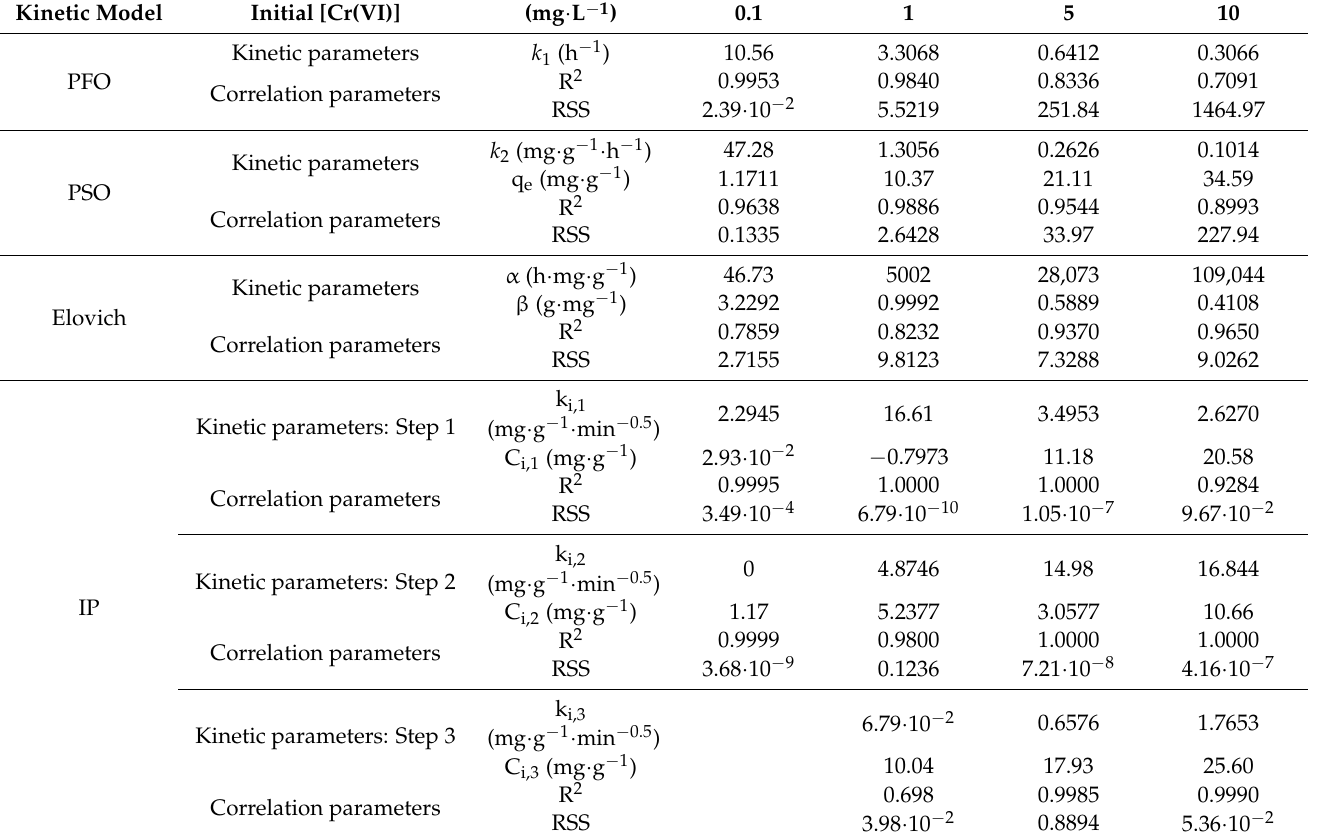
Table A3. Adjusted kinetic and correlation parameters of different kinetic models fitted to